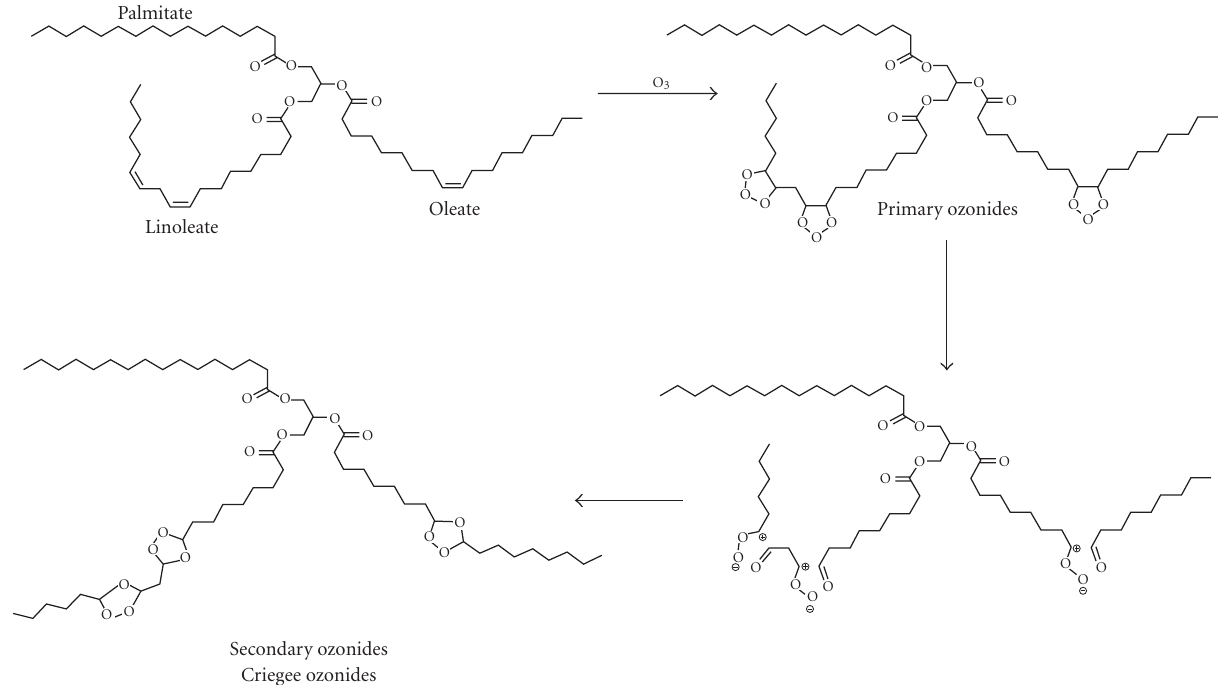
Figure 1: Representative chemical structures of ozonated derivatives which are formed by chemical reaction of ozone with unsaturated triglycerides. The primary ozonides are transient, unstable species which rearrange in the normal, secondary ozonides also known as Criegee